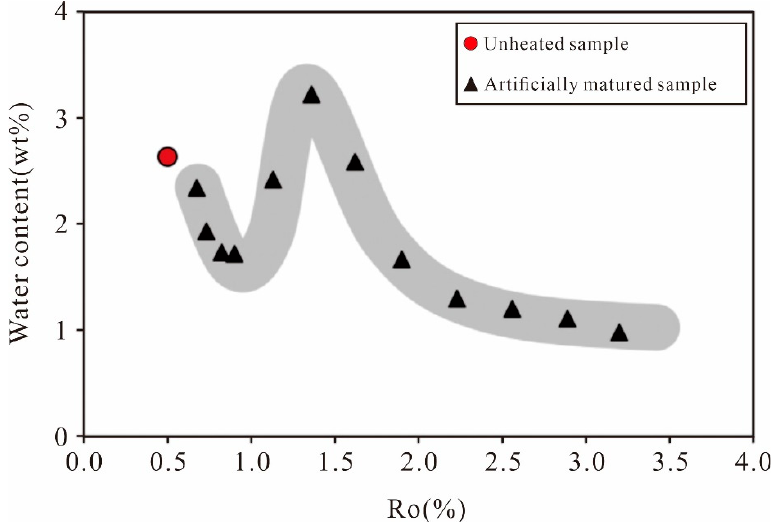
Figure 5. Correlation between the maturity and water content of an organic-rich shale. The data are based on a thermal simulation experiment of this shale [156].